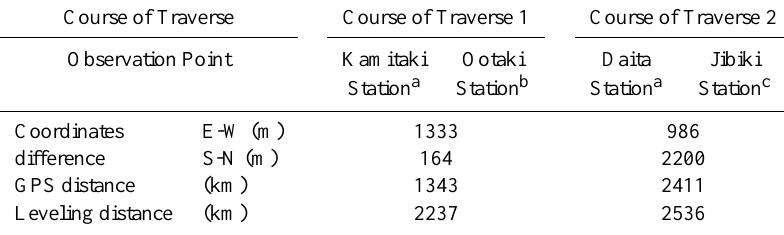
Table 2. GPS analysis conditions.